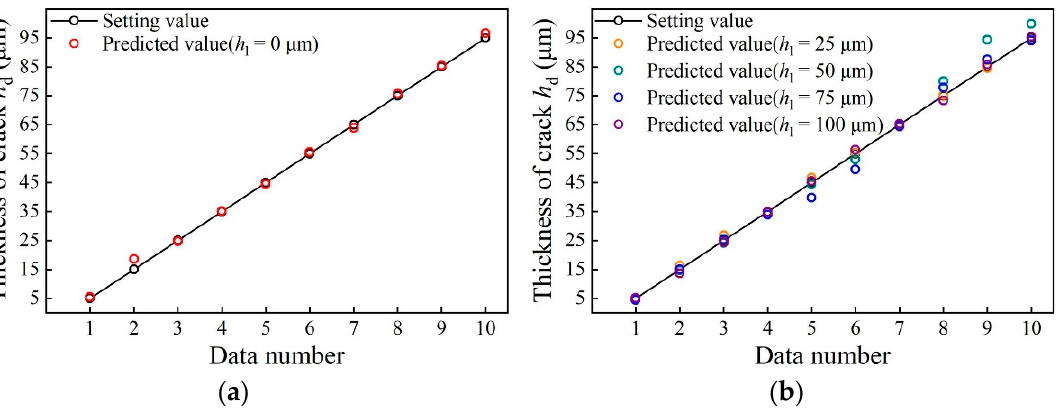
Figure 9. Predicted results for the thickness of cracks ( h c = 225 μ m): ( a ) Interface cracks; ( b ) Internal cracks.